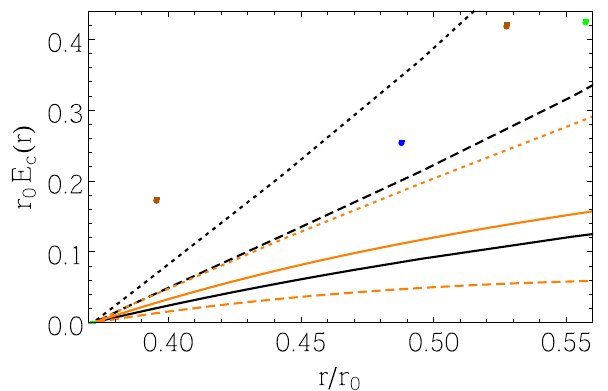
Fig. 8 Comparison to the lattice data for E d . The solid black line cor- responds to the NLO result at fixed scale ν = 2 / 0 . 263821 r − 1 dashed black line corresponds to the NLO result setting ν = 2 / r . The dotted lines correspond to the LL (orange) and NLL (black) results setting ν us = C A α(ν)/ r and ν = 2 / r